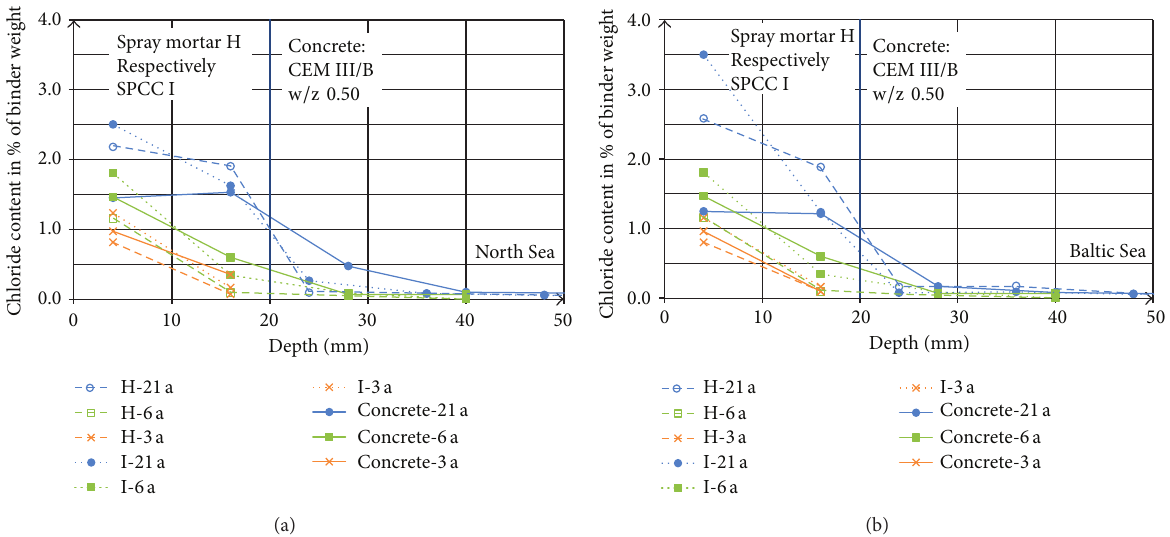
Figure 10: Chloride profiles of concrete slabs coated with mortars H and I after 3, 6, and 21 years’ exposure on the North Sea (a) and Baltic Sea coast (b).